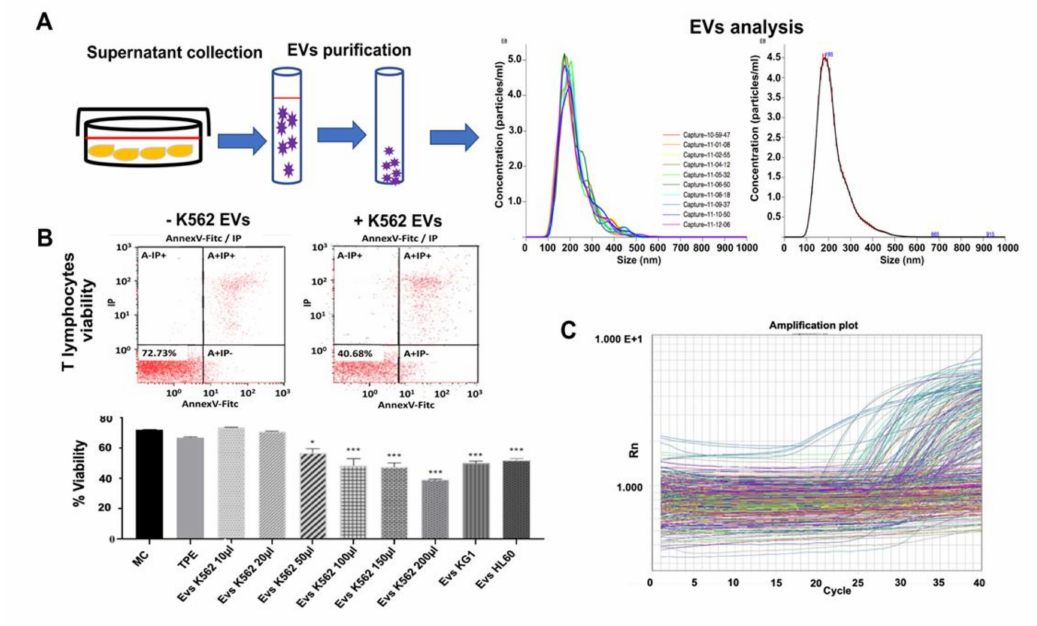
Figure 2. Myeloid leukemia cell line-derived EVs induce cell death in healthy donors (HD) T lymphocytes. ( A ) Characterization of K562-derived EVs. K562 EVs were characterized by